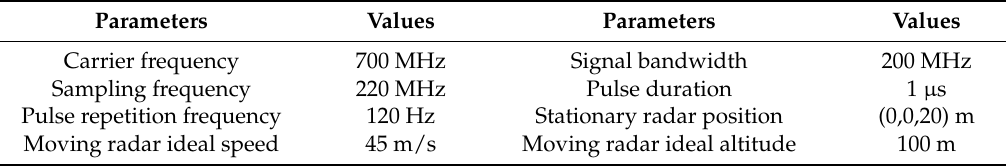
Table 1. Parameters of the simulated OS-BFSAR